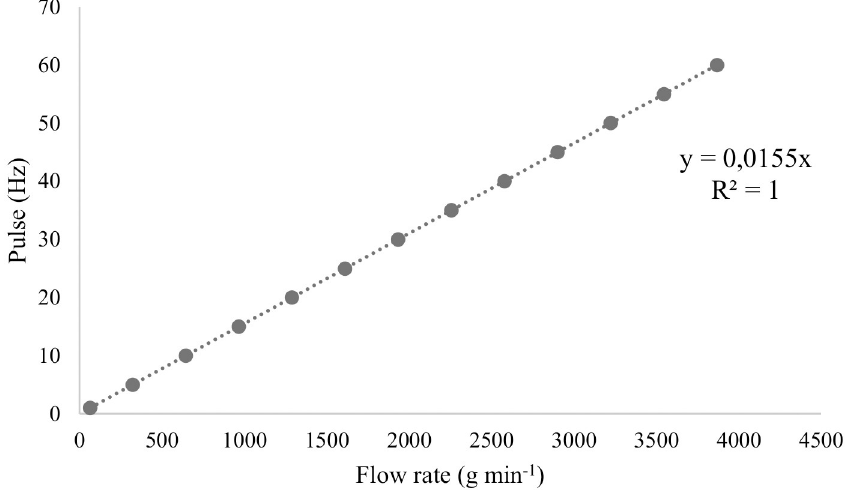
Fig 2. Calibration curve as a function of flow rate.